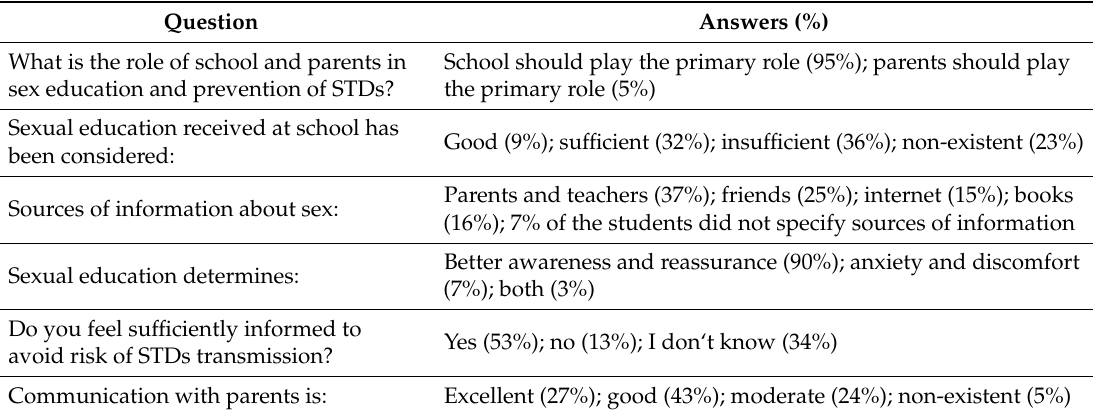
Table 1. Results of the first section of the